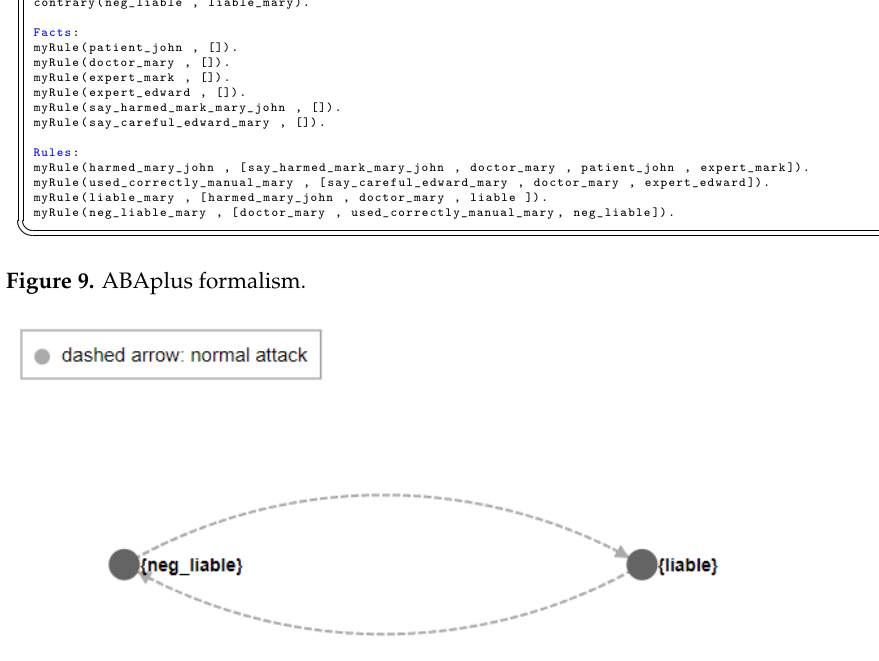
Figure 10. ABAplus assumption